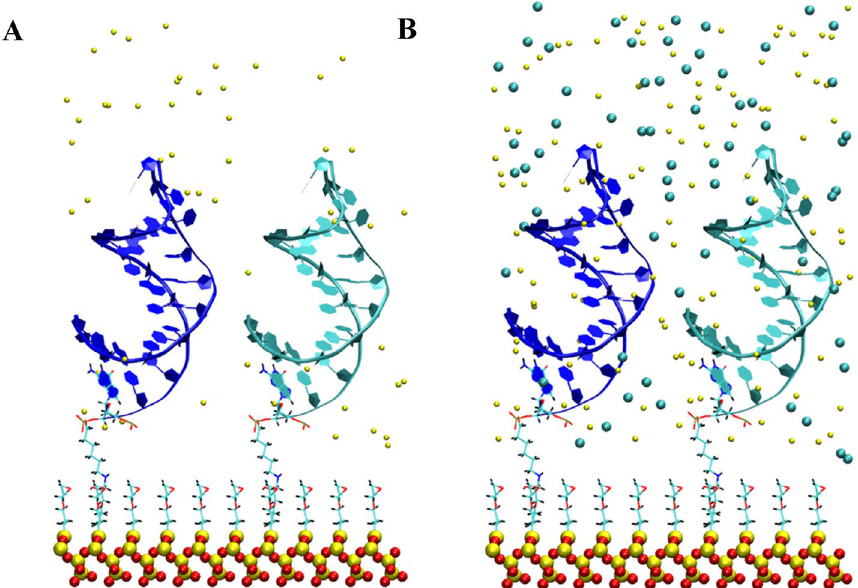
Figure 7. Representative starting configurations for different ion concentrations. ( A ) Configuration 5a corresponds to the neutralized system and ( B ) Configuration 5b corresponds a 0.8 M solution after neutralization. Water atoms are not displayed. Sodium ions are shown in yellow ( A , B ) and Chloride ions are shown in cyan ( B